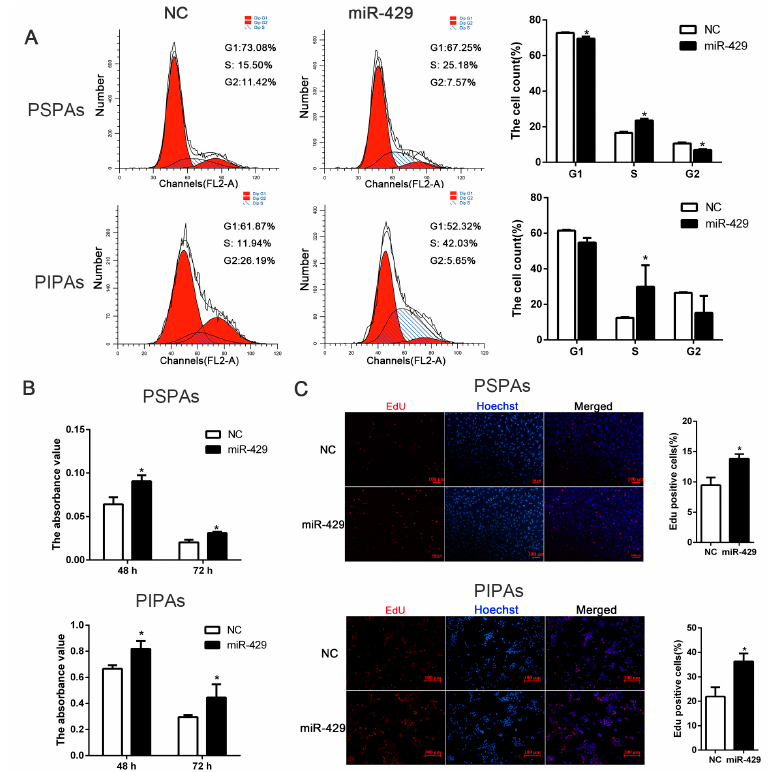
Figure 6. miR-429 significantly enforced proliferation of PSPAs and PIPAs . miR-429 agomir or negative control was transfected into PSPAs and PIPAs when the density reaching 30%. ( A ) Flow cytometry detected cell number of G1, S and G2 phase at 48 h of transfection; ( B ) CCK-8 detected cell vitality at 48 h of transfection; ( C ) EdU staining assayed the number of proliferous cells, positive cells were stained by EdU (red) and total cell nuclei were stained with Hoechst (blue) (bar size = 100 µm). Statistical results are indicated as means ± SEM; n = 3; * p < 0.05. G1, Gap 1 phase; G2, Gap 2 phase; S, Synthesis phase.